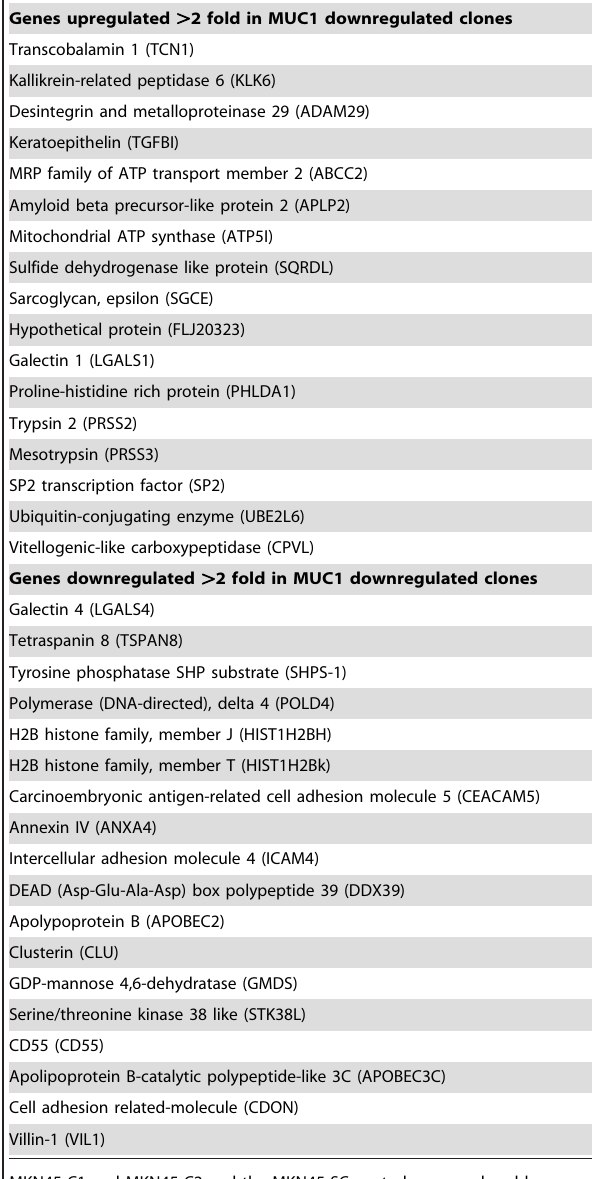
Table 1. Oligonucleotide microarray results by comparison between MKN45-C1/MKN45-C2 and MKN45-SC control cells, by order of